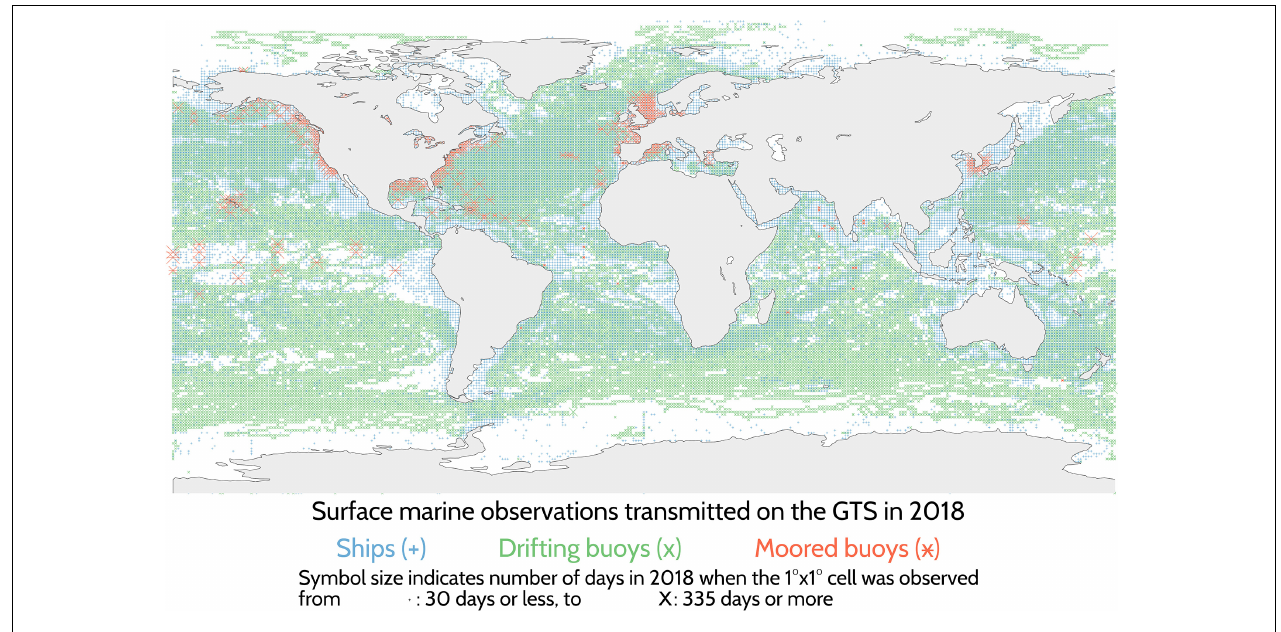
FIGURE 4 | Data coverage by the three major components of GOS (i.e., ships, drifting buoys, and moored buoys) based on information received by Météo-France through the GTS in 2018 (see legend for symbol